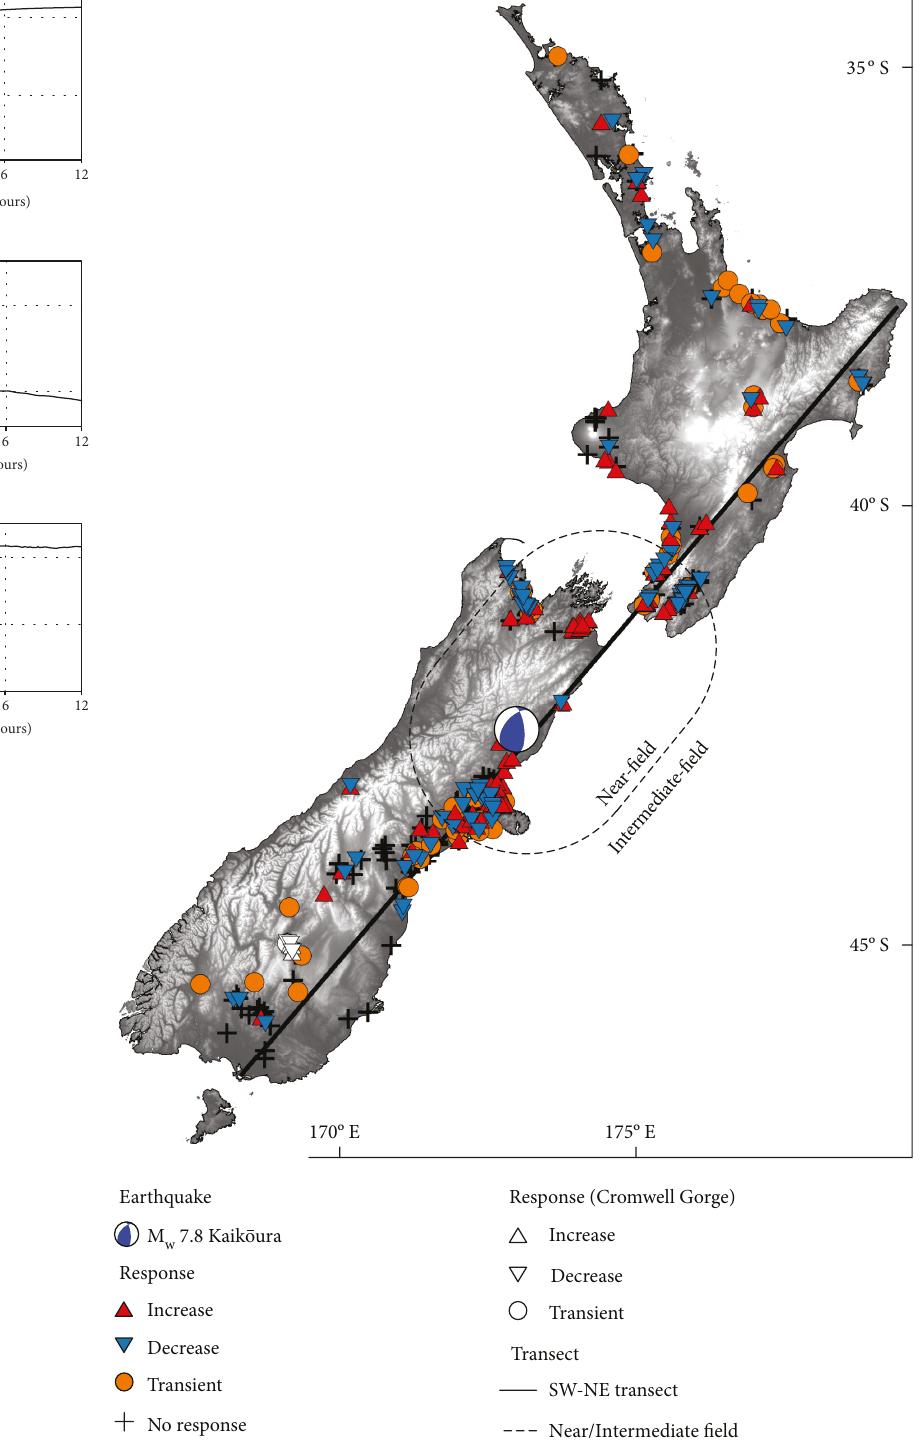
Figure 2: Three examples of earthquake-induced groundwater level responses characterised and the spatial distribution of water level changes induced by the 2016 M 7.8 Kaik ō ura earthquake. (a) Persistent water level increase. (b) Persistent water level decrease. (c) w Transient water level change. (d) Spatial distribution. Sampling intervals are 15 minutes (a, b) and 5 minutes (c). Responses in Cromwell Gorge are highlighted separately. The thick black line shows a transect approximately parallel to the long axis of the surface rupture zone; see Figure 8 for water level changes along this